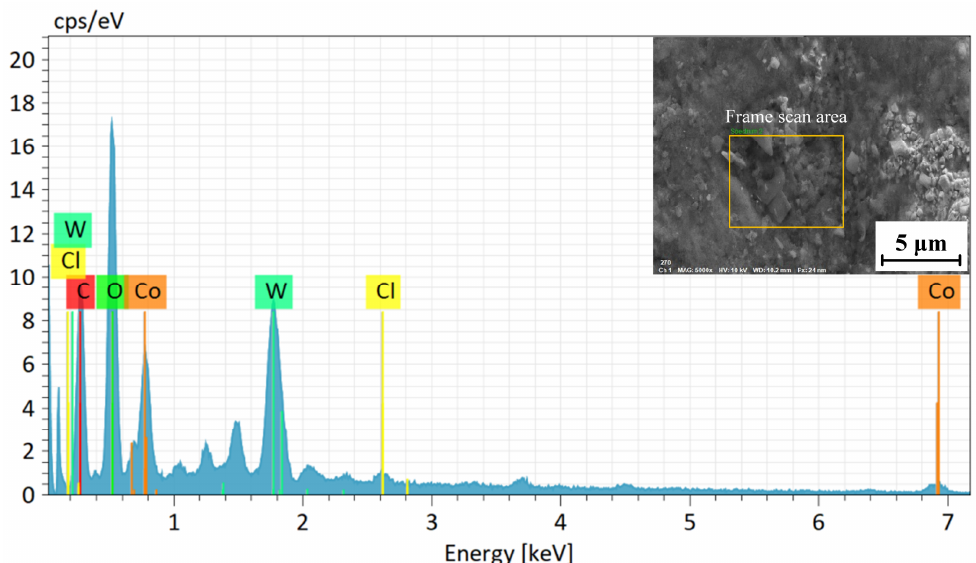
Figure 24. EDS analysis of the WC-12CO coating surface after corrosion.